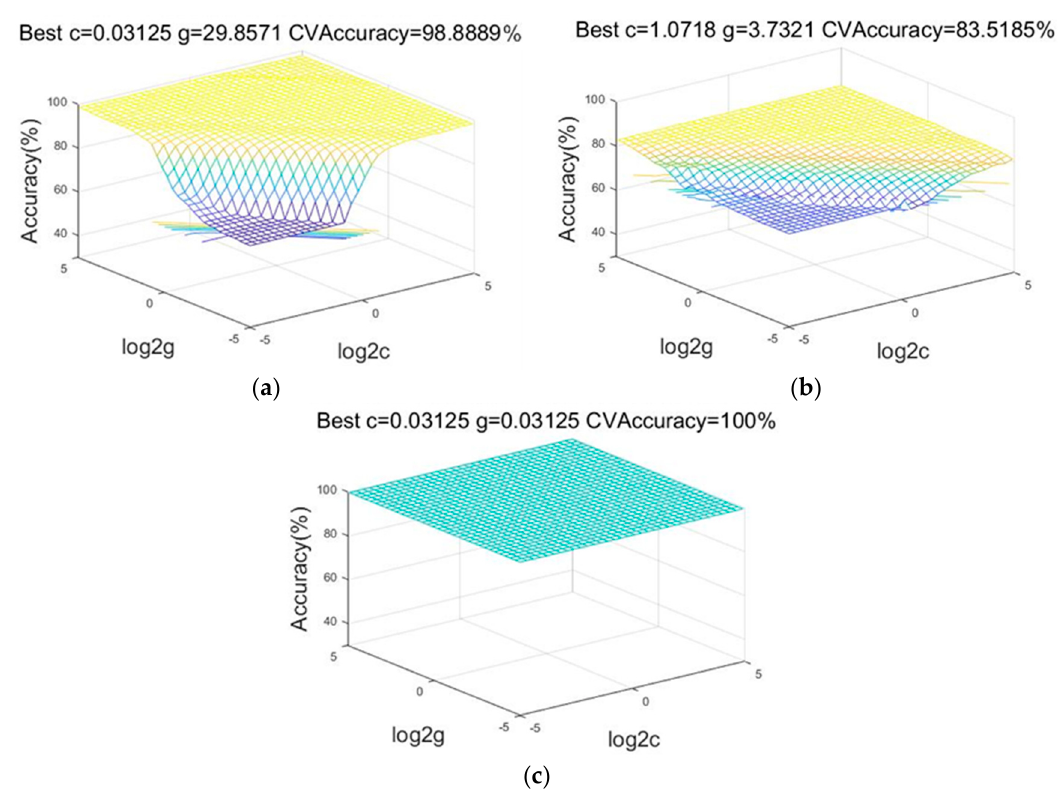
Figure 10. Average recognition rate contour map. ( a ) Kurtosis factor. ( b ) Center of gravity frequency. ( c ) IMF1 energy. Table 1. Accuracy of time domain eigenvalue